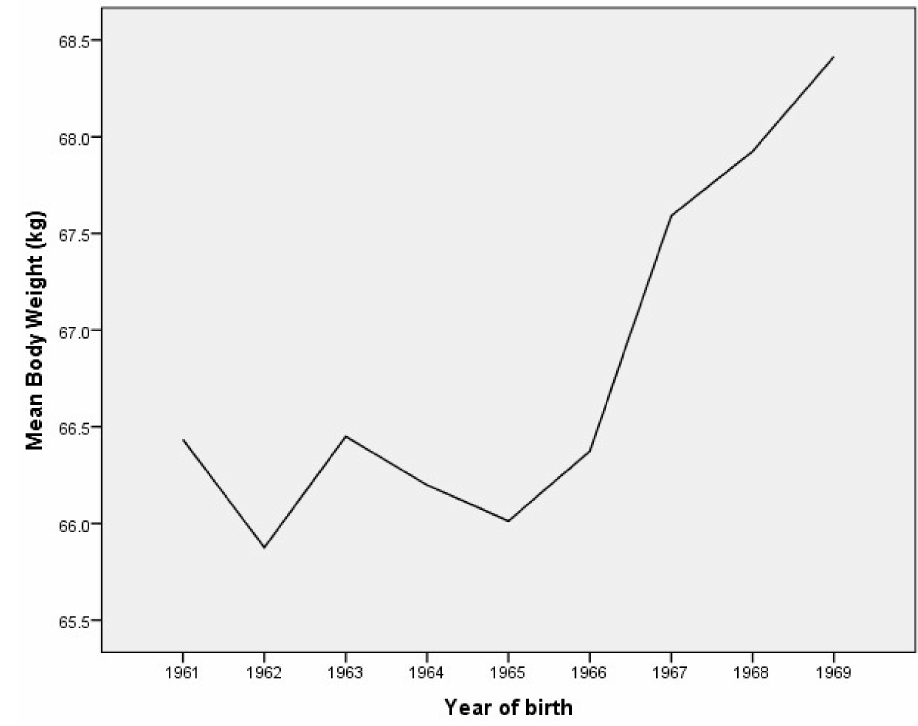
Figure 2. The mean body weight trends by year of birth in young males.